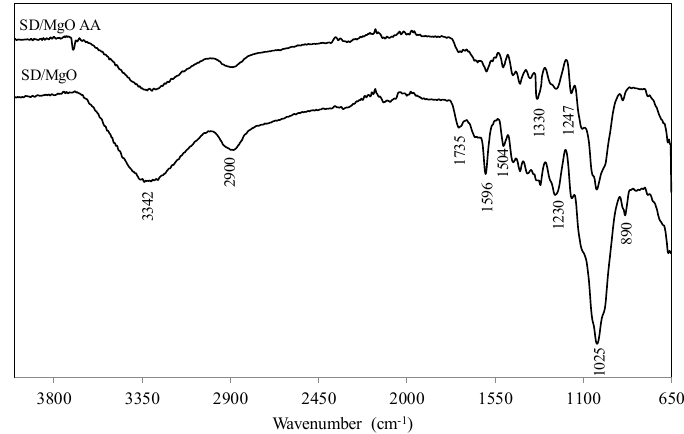
Fig. 6. The FTIR spectrums of SD/MgO before and after adsorption (SD/MgO AA) of MB. Fig. 6: The FTIR spectrums of SD/MgO before and after adsorption (SD/MgO AA) of